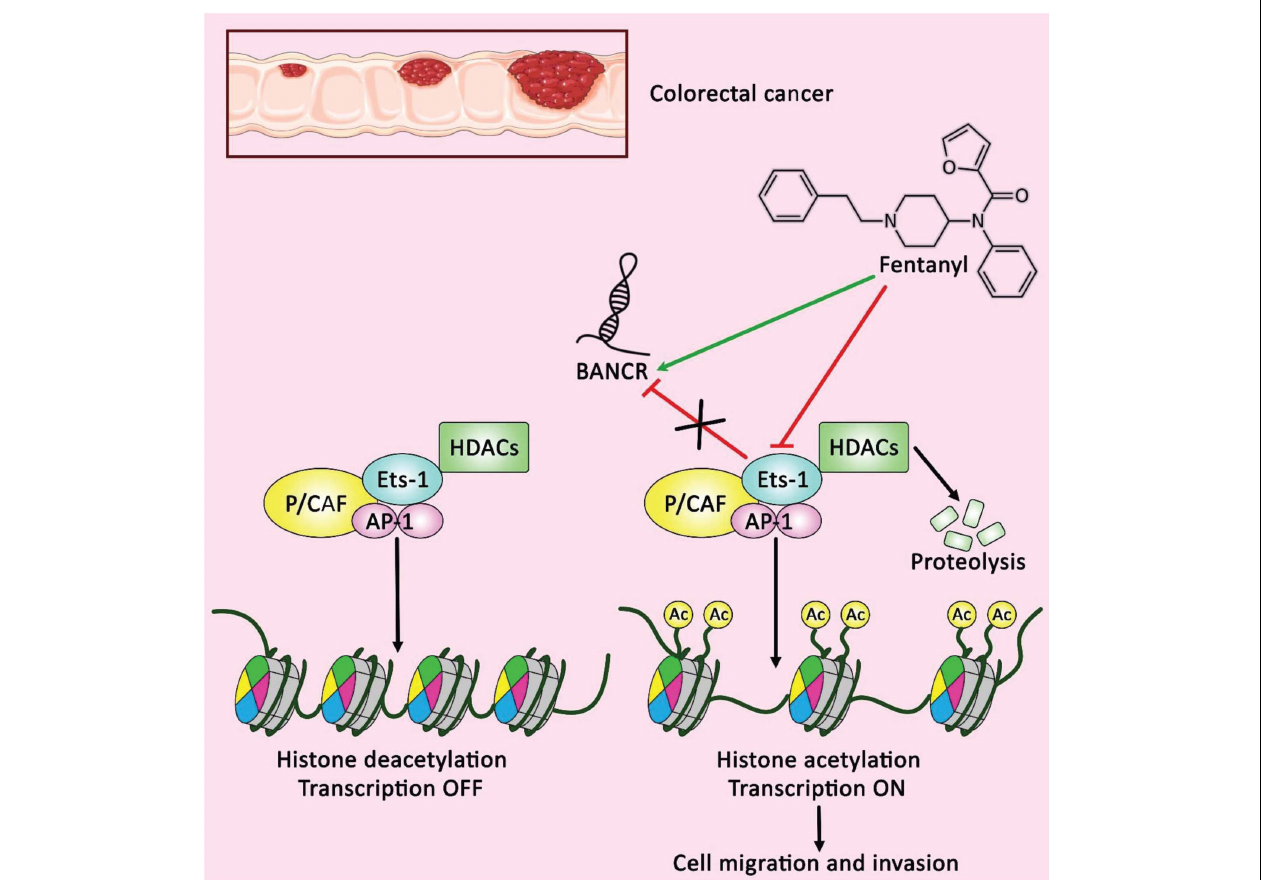
FIGURE 2 | A schematic representation of the potential role of fentanyl as an anti-tumor drug in colorectal cancer cells. Accumulating evidence illustrates that Ets-1 could negatively regulate the expression of BANCR through the deacetylation of histones H3 within BANCR promoter. The regulatory role of fentanyl on reducing the expression level of Ets-1 and inducing BANCR upregulation could have a significant part in decreasing cell clonal formation, as well as cell migration and invasion in colorectal cancer (Li A.-x. et al., 2015). Therefore, lncRNA BANCR could play an effective role as a tumor suppressor in the regulation of colorectal cancer cells (Li A.-x. et al., 2015). Green arrow indicates the regulatory role of fentanyl on the overexpression of lncRNA BANCR, red arrows depict the inhibitory role of fentanyl on the expression of Ets-1, and the impact of Ets-1 on down-regulating the expression level of BANCR.